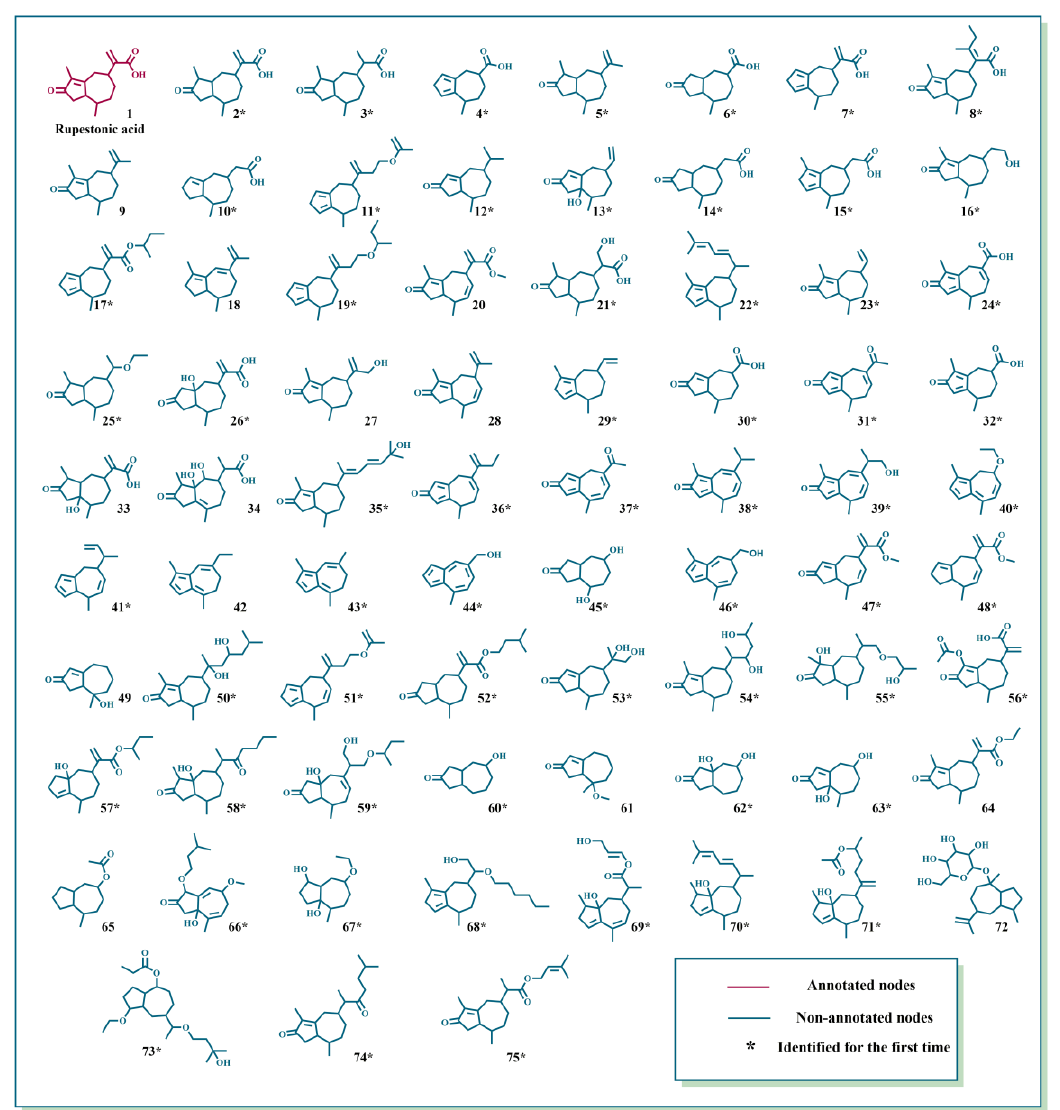
Figure 2. Structures of tentatively characterized sesquiterpenoids within Gynura divaricata (L.) DC.